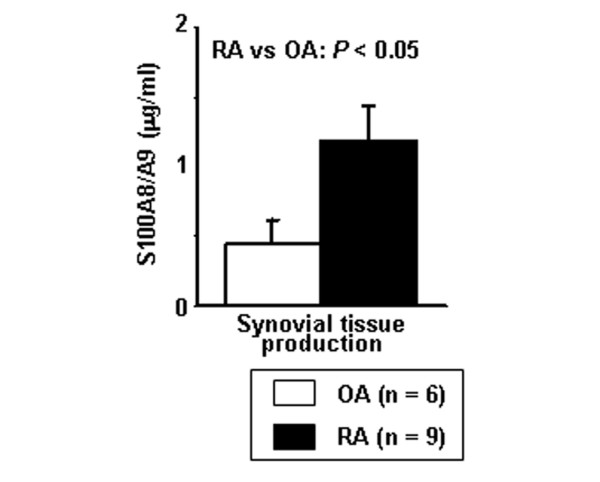
Secretion of S100A8 and S100A9 proteins from isolated synovial tissue (ST) cells of rheumatoid arthritis (RA) and osteoarthritis (OA). Freshly isolated ST cells (1 × 106 cells per ml in culture medium with 10% fetal calf serum) were incubated without any stimulation for 72 hours. Culture supernatants were measured in duplicate for the S100A8/A9 heterodimer by enzyme-linked immunosorbent assay. Values are the mean ± standard error of the mean. n, number of samples tested.